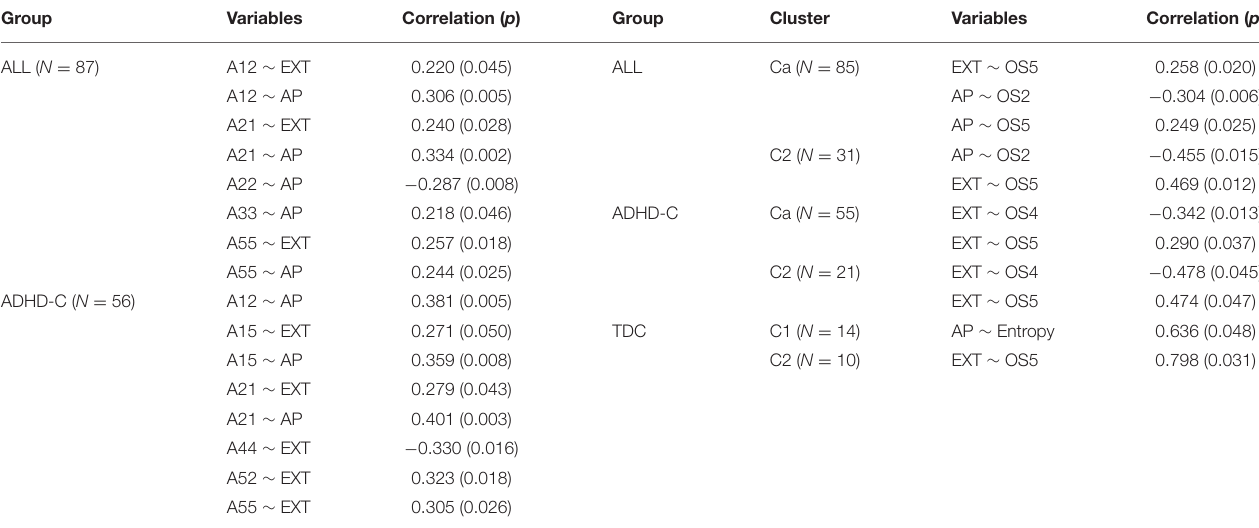
TABLE 1 | Correlation analysis results. Group Variables Correlation ( p ) Group Cluster Variables Correlation ( p